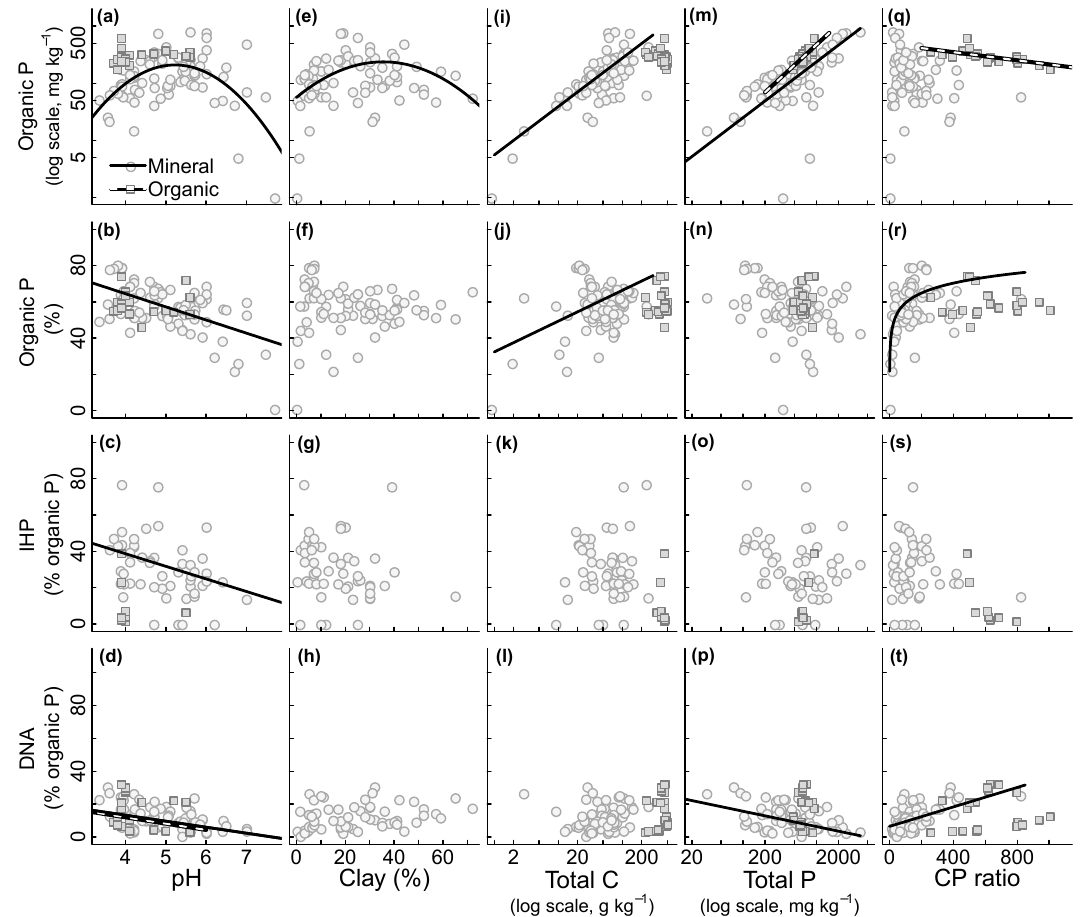
Figure 3. Relationship between edaphic properties and soil organic phosphorus (P) composition in NaOH-EDTA extract from soil mineral and organic layers on natural ecosystems. Note that the reported total P ( x axis) is the one obtained by digestion and usually comprise the residual P non-recovered by the NaOH-EDTA extractant. Regression models: mineral layer, log(total P o mgkg − 1 ) = − 3 . 61 + 2 . 27pH − 0 . 22pH 2 , r 2 = 0 . 34 ( n = 80); mineral layer, total P o (%) = 93 . 4 − 7 . 24pH, r 2 = 0 . 35 ( n = 80); mineral layer, inositol